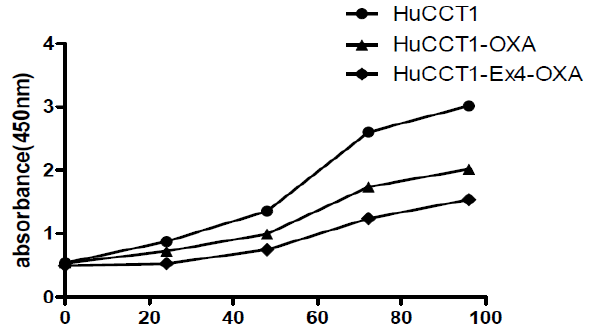
Figure 4. Proliferation rate of intrahepatic cholangiocarcinoma cells treated with oxaliplatin and